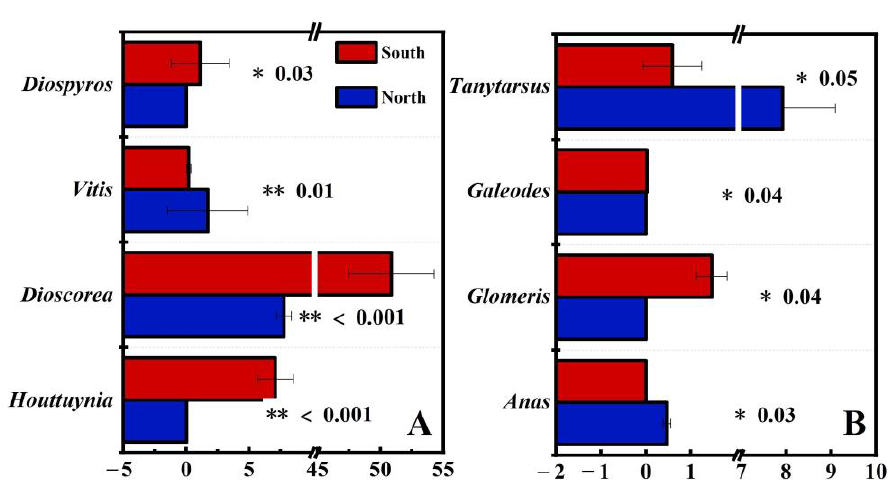
Figure 6. PCOA analysis of wild boars in different regions.